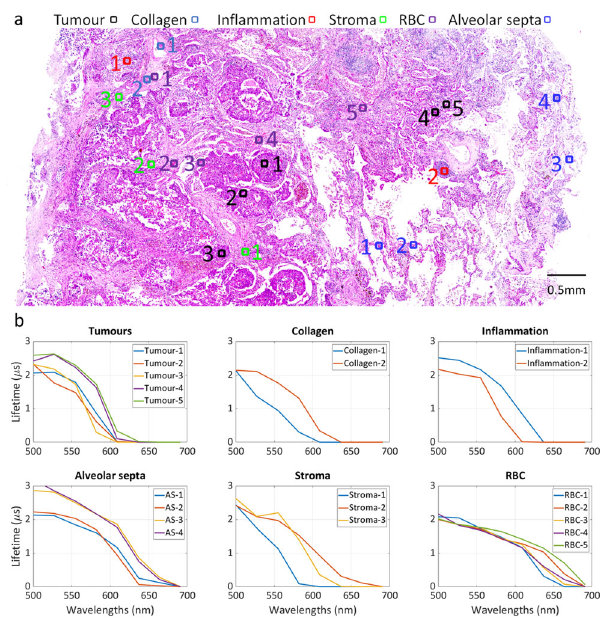
Fig. 7 Absolute spectral lifetime of six different types of cells, including tumour, collagen, in fl ammation, stroma, red blood cell (RBC) and alveolar septa. a Annotated locations of the cells are illustrated in the histology image. b The corresponding lifetime values for each cell type are presented across wavelengths in [500 nm, 680